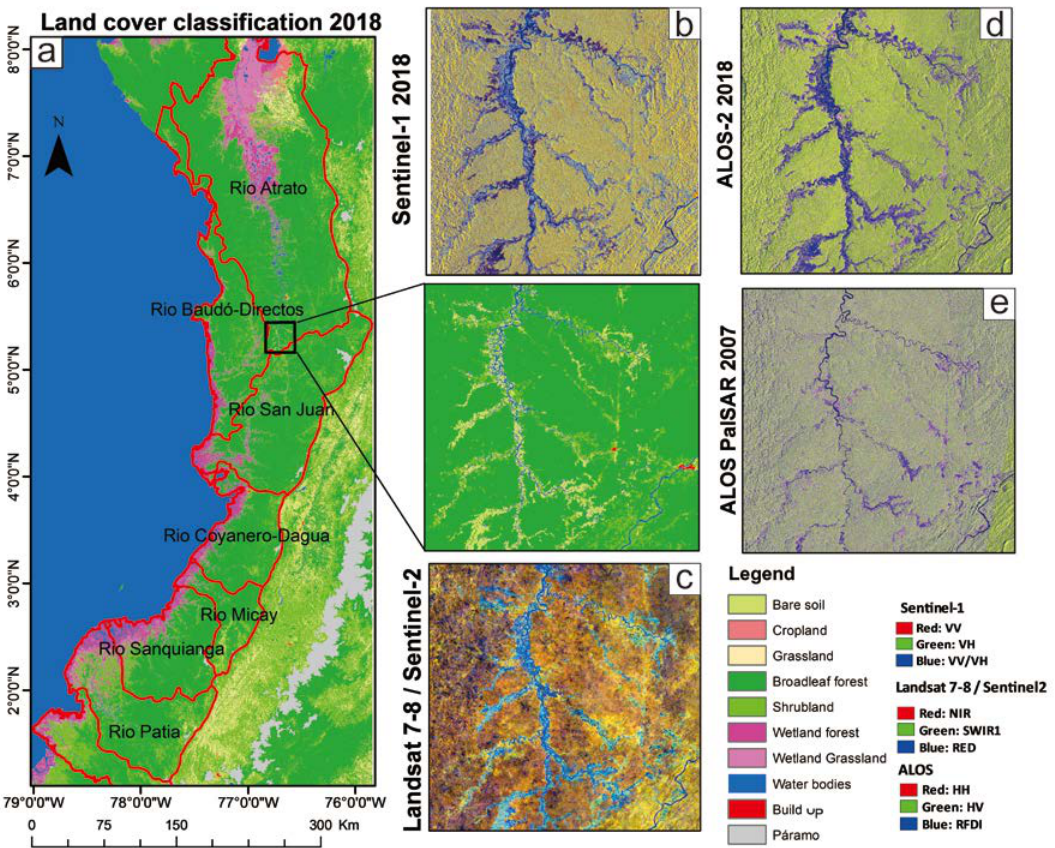
Figure 3. (a) Land cover classes’ extent for the Pacific region with a zoom into the Quito River tributary of the Atrato River, as an example of deforestation due to mining activities. ( b ) Sentinel C-band (2018). ( c ) temporal composite Landsat7-8 / Sentinel-2 ( d ) ALOS PalSAR L-band (2018), and ( e ) ALOS PalSAR 2007. RFDI stands for radar forest degradation index and HH, HV, VV, VH are di ff erent polarizations of radar images. See Appendix A for web mapping